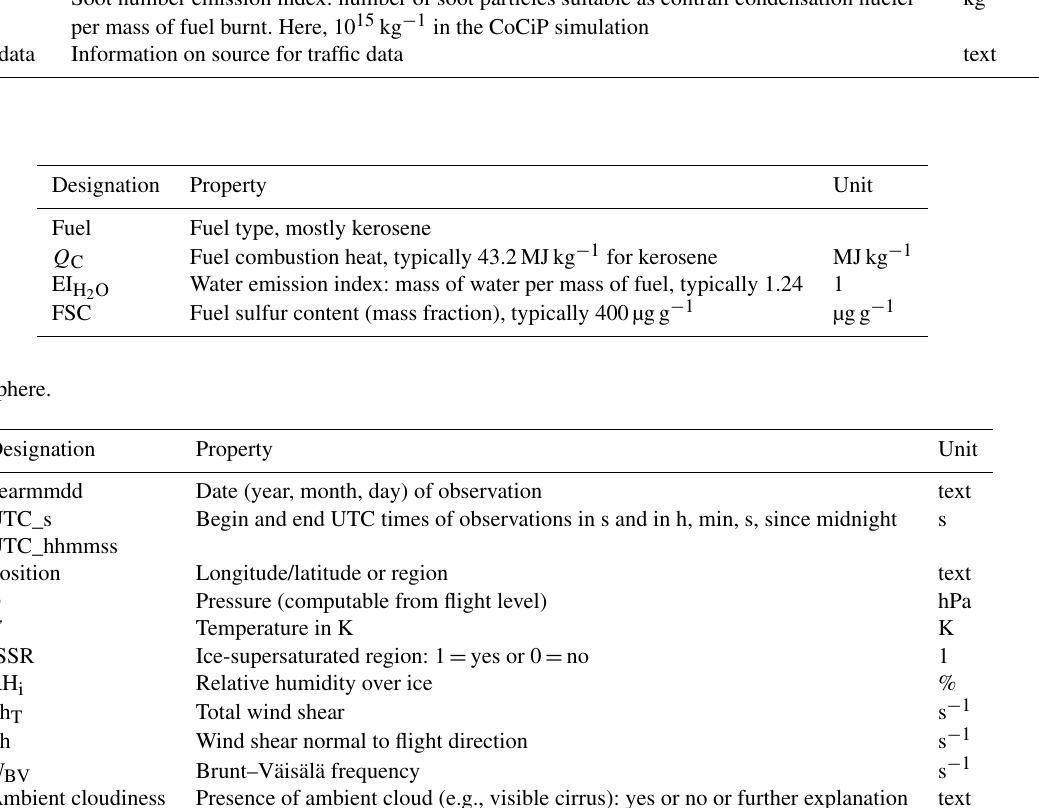
True heading (flight direction): 0 ◦ : northbound; 90 ◦ : eastbound